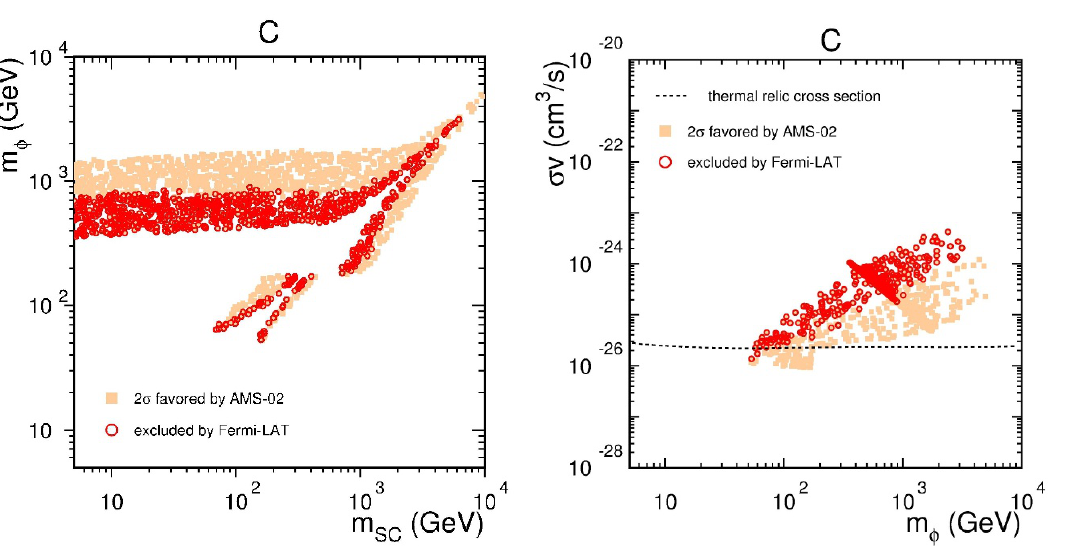
Figure 7 . Left: the AMS-02 favored region of masses ( m (cid:30) vs. m S model C . Right: the AMS-02 favored region of cross sections ( (cid:27)v vs. m (cid:30) ). Figure 8 . Left: the AMS-02 favored region of masses ( m X vs. m S model V . Right: the AMS-02 favored region of cross sections ( (cid:27)v vs. m X ).